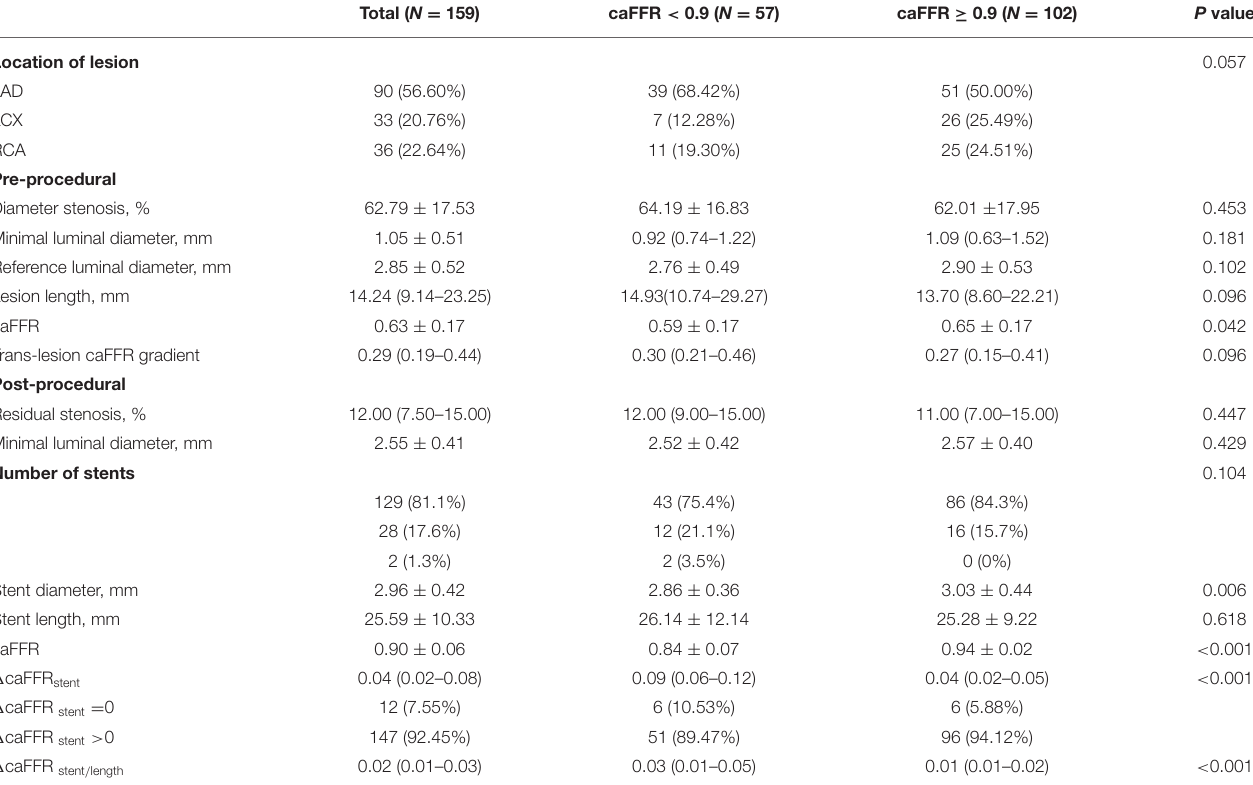
TABLE 2 | Pre- and Post-procedural characteristics of study vessels ( N = 159).